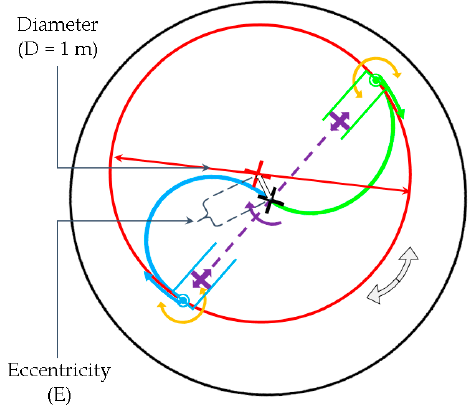
Figure 3. Turbine motion constrains in the structural simulation.